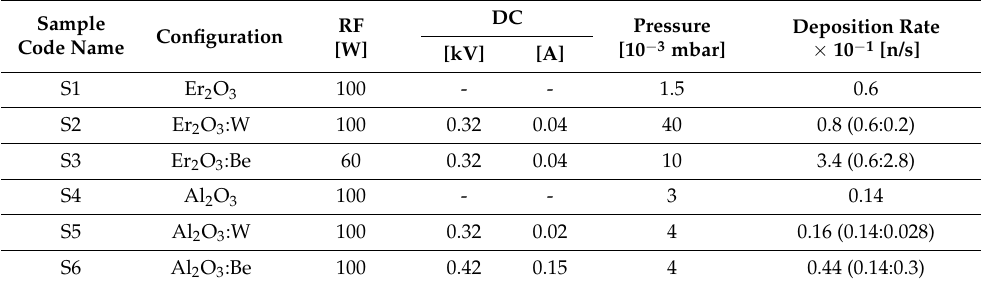
Table 1. Samples code name for each configuration and their representative deposition parameters.